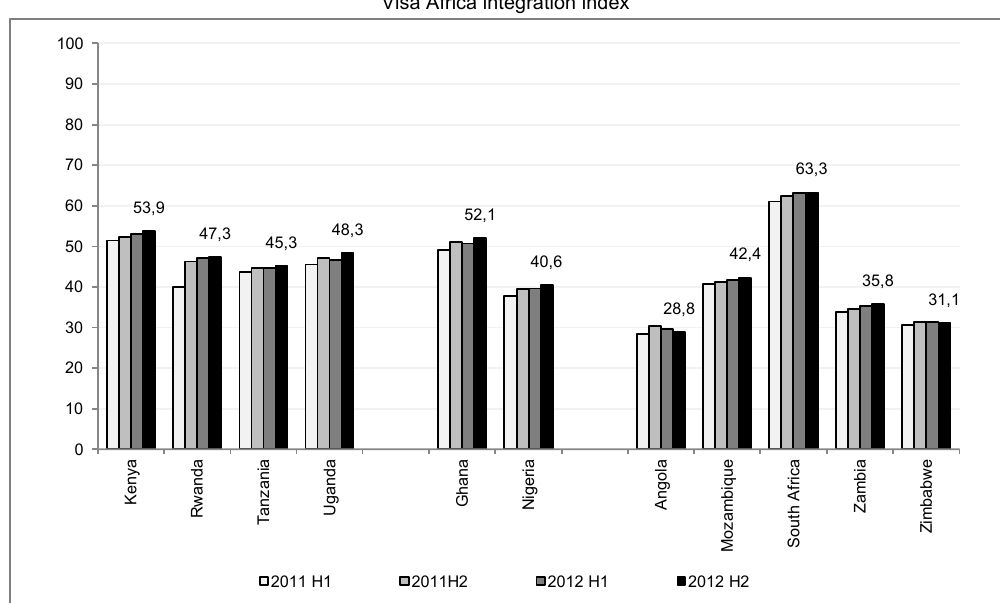
Figure 4 Visa Africa integration